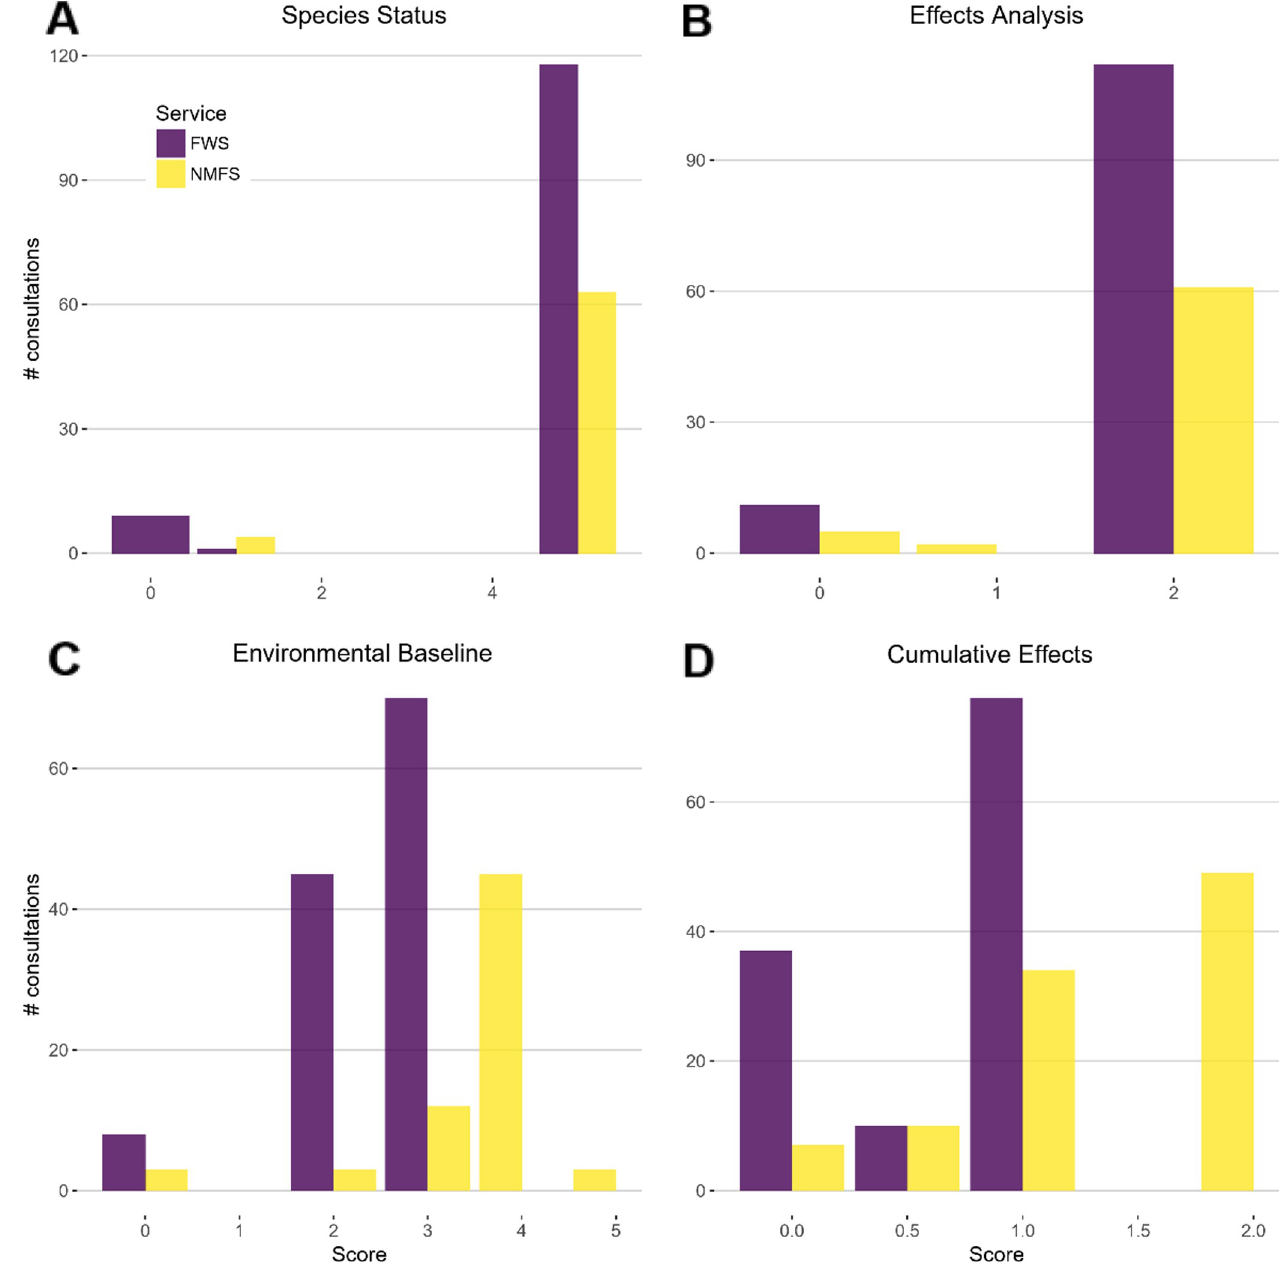
Fig 2. Individual components of consultations produced by NMFS showed higher completeness scores than those by FWS on average. However, the only component that statistically differed between the Services was the Environmental Baseline ( z = 5.3993, p = 6.691e-08; OR NMFS = 2.6e 4 [95% CI = 6.5e 2 –1.1e 6 ]). The scores are the raw completeness scores for formal consultation